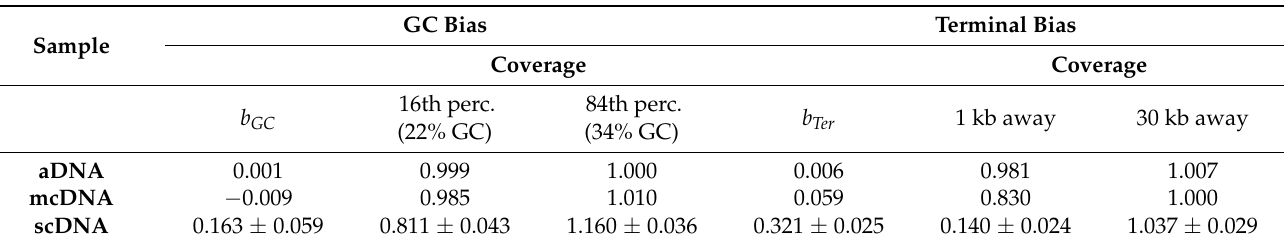
Table 1. Quantitative analysis of genome representation. GC Bias . Linear regression of normalized coverage on GC content. GC Bias estimates are expressed as change of normalized coverage every 10% change in GC content. Normalized coverage is shown for DNA with GC content one standard deviation (sd) above (~22%) and below (~34%) the mean (28% GC). Perc., percentile. b , regression coefficient. Terminal Bias . Linear regression of normalized coverage on distance from chromosome ends (every 10kb). True relationship is parabolic. Normalized coverage is estimated for regions that are 1 and 30 kb away from either chromosome ends. Terminal Bias was calculated on the 115 telomere-capped chromosomes of P. tetraurelia . aDNA-seq, artificially generated DNA sequencing. mcDNA-seq, mass culture DNA sequencing. scDNA-seq, single-cell DNA sequencing. Mean ± sd of the mean is shown for 11 scDNA-seq